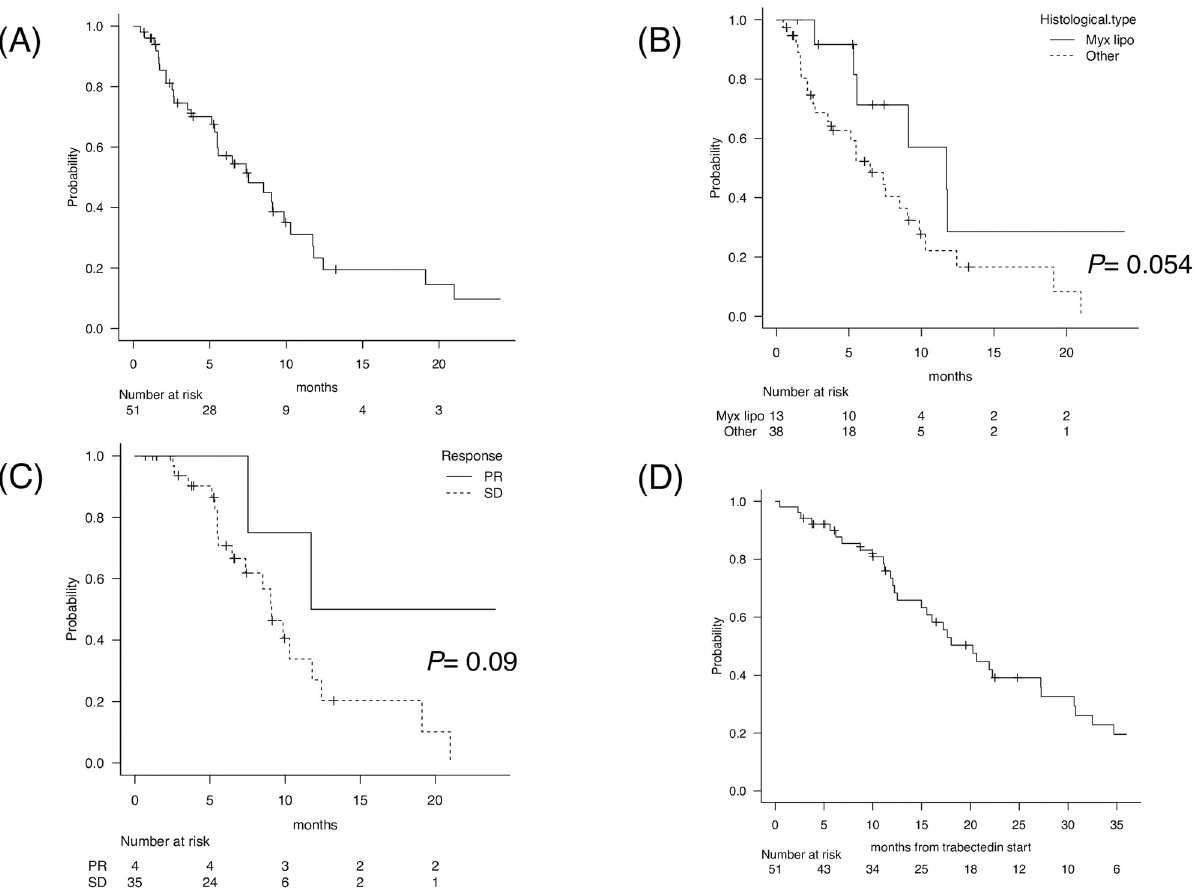
Fig 1. PFS and OS data in sarcoma patients who received trabectedin. ( A ) PFS in all 51 sarcoma patients, ( B ) subgroup analysis for PFS between patients with myxoid liposarcoma and those with other histological subtypes, ( C ) subgroup analysis for PFS between patients who achieved PR and SD following trabectedin, and ( D ) OS in all 51 sarcoma patients. PFS, progression-free survival; PR, partial response; SD, stable disease; OS, overall survival; myx lipo, myxoid liposarcoma.